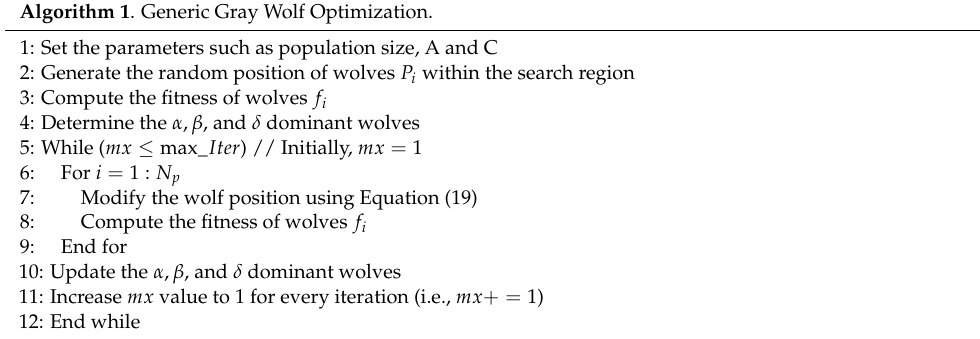
Algorithm 1 . Generic Gray Wolf